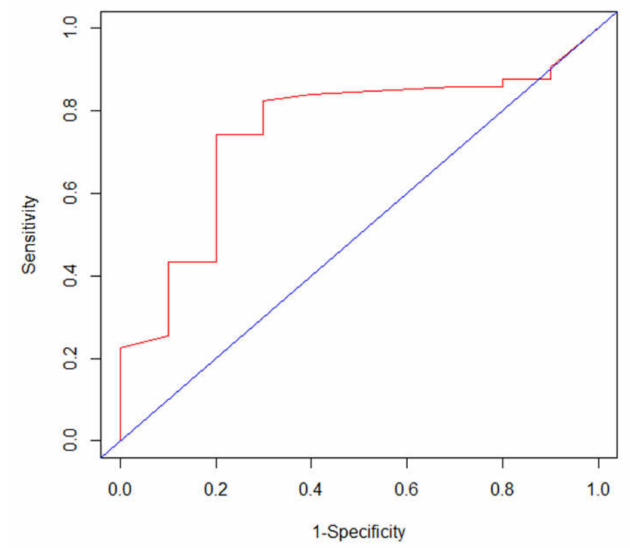
Figure 2. Time-dependent receiver operating characteristic curve analysis of distant metastasis-free survival prediction based on the SUV LN / SUV Tumor ratio in 112 patients with esophageal squamous cell carcinoma (ESCC). The area under the curve was 0.754 ( p < 0.01, 95% CI 0.593–0.916), and 0.39 was determined as the best SUV LN / SUV Tumor ratio cuto ff value for survival